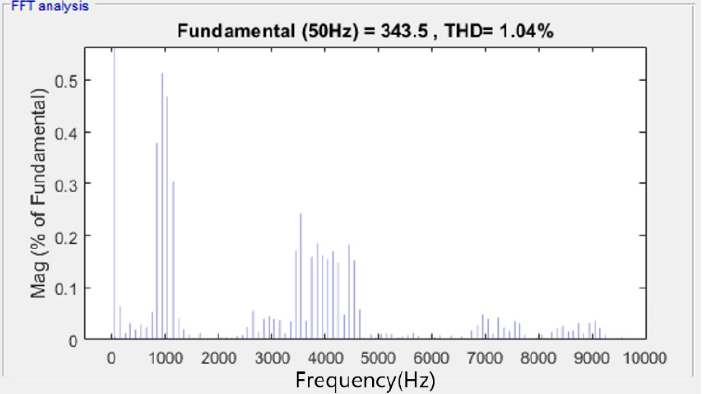
Figure 10. Four H-bridge CHB THD for PS PWM and non-equal sources worst switching sequence 1243.